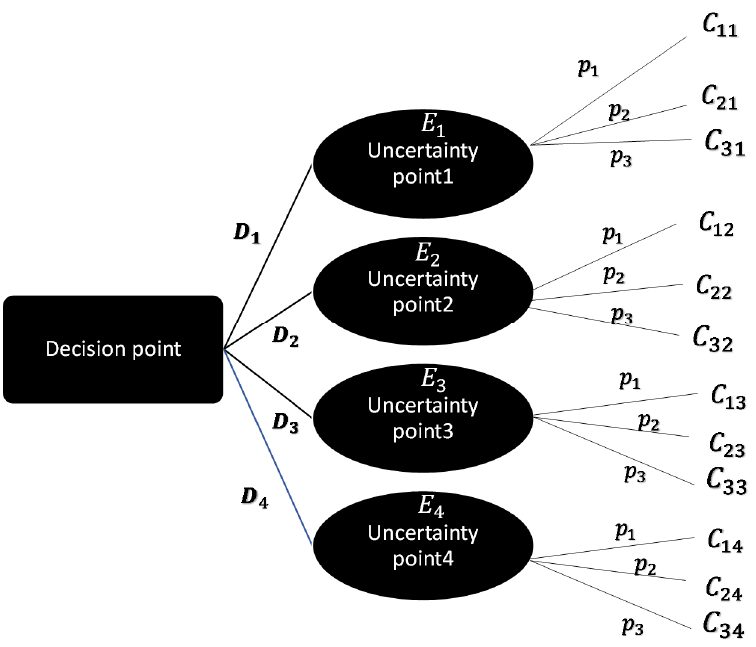
Figure 3. Illustration of the uncertainty through a scenario tree that consists of two stages, where the first stage is when the investment decision is taken (“decision point”) and the second stage is when the uncertainty resolves (i.e., the planner learns which scenario realizes). Table 2. Description of the availability of technologies for each of the candidate investment decisions. Conventional network reinforcement is the only technology available to D 1 the planner. D 2 The planner does not make any investments at all (Do-nothing approach). D 3 Smart Charging of EV is the only technology available to the planner. Both conventional network reinforcement and Smart Charging of EV are available D 4 to the